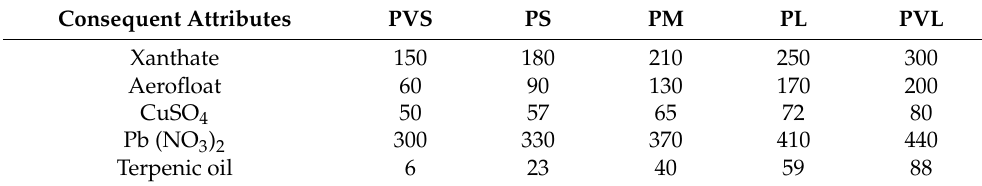
Table 4. Output referential values of consequent attributes in antimony flotation (mL/min). Consequent Attributes